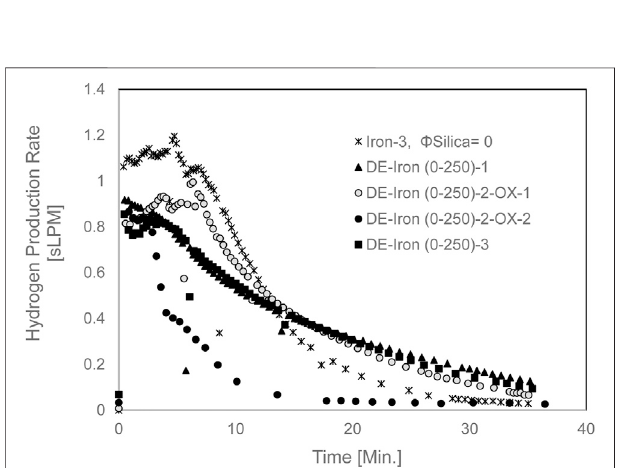
FIGURE 9 | Hydrogen yield for mixed iron and silica (45 – 106 µm) with 0.67 silica volume fractions at 950 ° C set furnace temperature, pure iron furnace set temperature is 850 ° C.